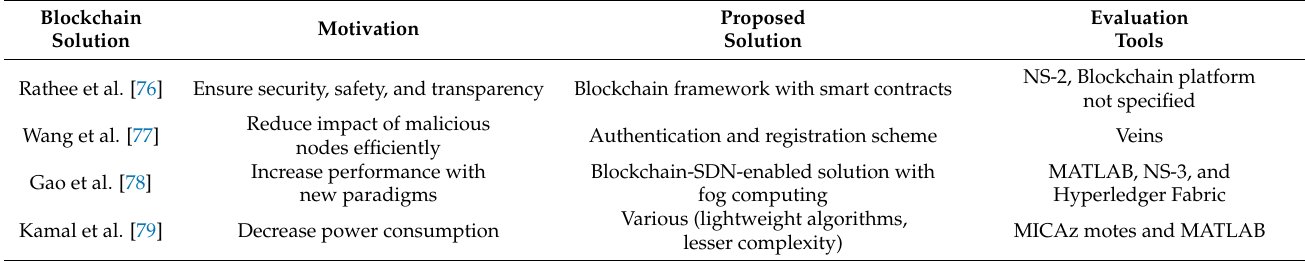
Table 3. Comparison of Blockchain